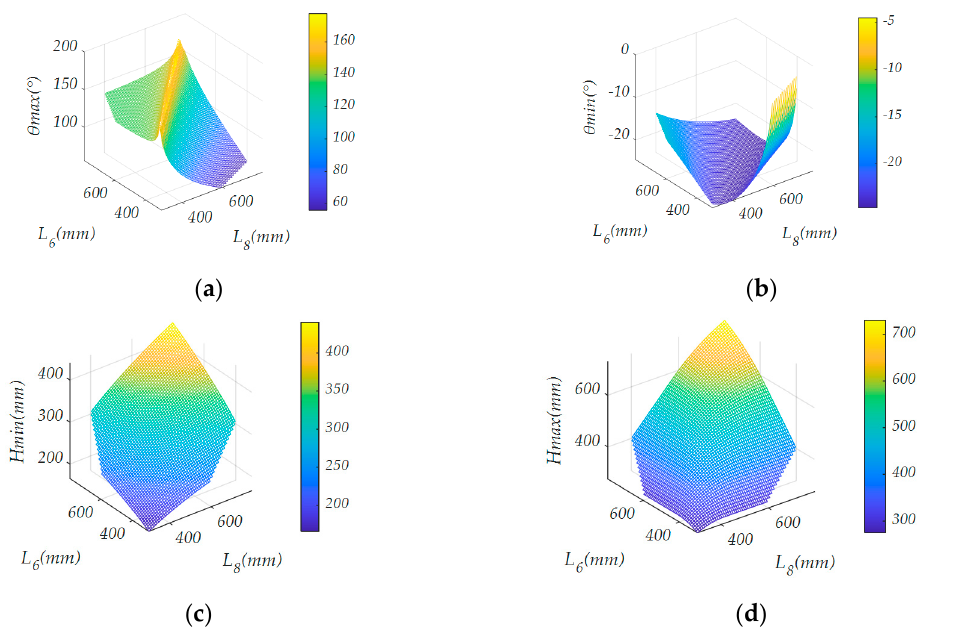
Figure 4. The relationship between each evaluation index and the length of two connecting rods: ( a ) the relationship between the maximum reachable angle and the length of the connecting rod; ( b ) the relationship between the minimum reachable angle and the length of the connecting rod; ( c ) the relationship between the maximum reachable height and the length of the connecting rod; ( d ) the relationship between the minimum reachable height and the length of the connecting rod.